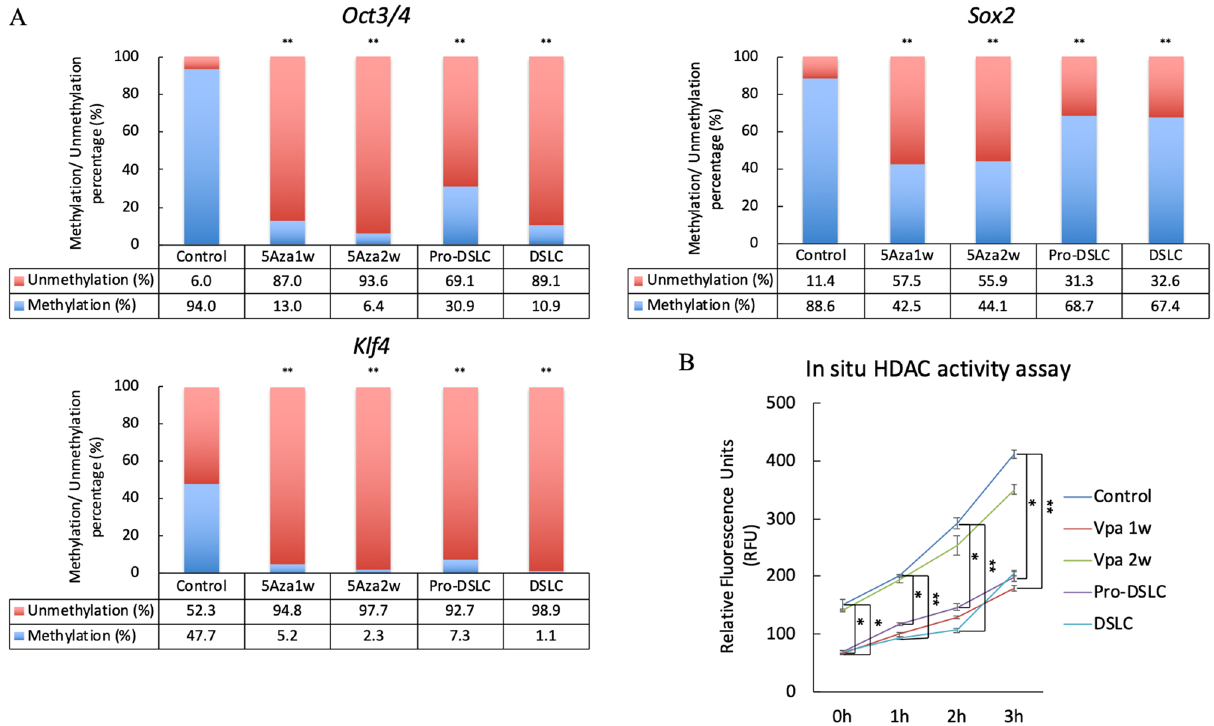
Figure 5. Results of the quantitative methylation-specific PCR (qMSP) ( A ) and in situ HDAC activity assay ( B ). DNA methylation of Oct3/4 , Sox2 , and Klf4 was analyzed using qMSP. The DNA methylation percentage levels of Oct3/4 , Sox2 , and Klf4 in the cells treated with 5Aza alone (5Aza1w, and 5Aza2w), Pro-DSLCs, and DSLCs were significantly lower than those in the controls (ERM cells) (** p < 0.01; χ 2 tests, n = 5). Each sample showed controls (ERM cells) (** p < 0.01, * p < 0.05; Kruskal–Wallis test, n =